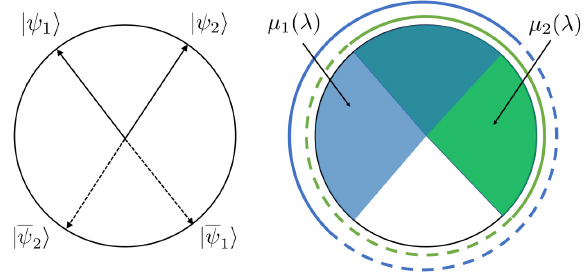
FIG. 3. Two pure states | ψ 1 (cid:13) and | ψ 2 (cid:13) are considered in UD, for which an optimal measurement corresponds to their orthog- (cid:13) and | ψ (cid:13) , respectively. The inconclusive out- onal states | ψ 1 1 comes are collected by a POVM element constructed by an equal mixture of given states. The structure is shared with UD of two states μ 1 (λ) and μ 2 (λ) , diagrammed by blue and green regions, respectively. The outer lines signify the supports of response functions. ξ 1 (λ) has the same support as ¯ μ 2 (λ) (green dashed line) and ξ 2 (λ) has the same support as ¯ μ 1 (λ) (blue dashed